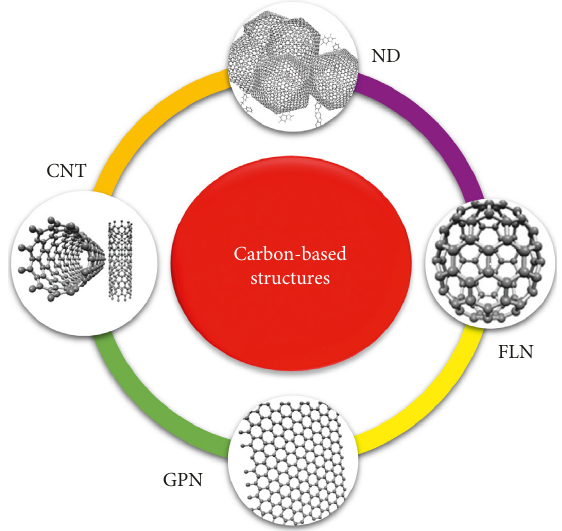
Figure 1: Carbon-based